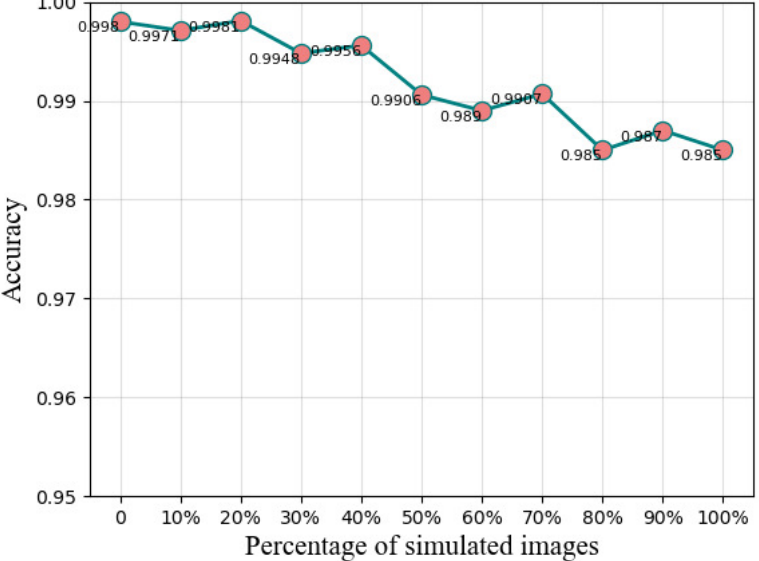
Figure 18. Hybrid Recognition Rate curve of electromagnetic simulation. The x -axis represents the ratio of substitution and the y -axis indicates the accuracy.